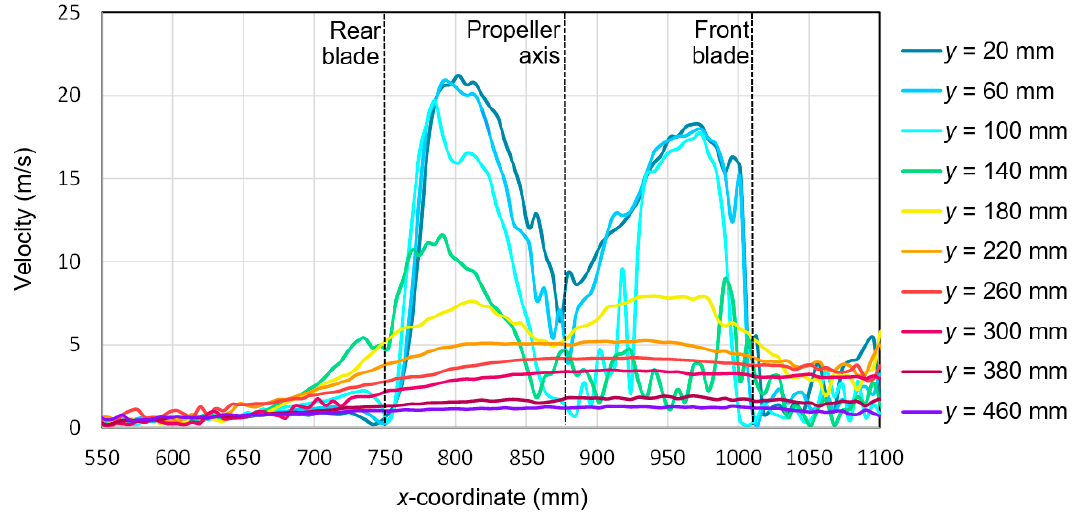
Figure 16. Resultant airflow velocities around the research object for the following configuration: angle of attack α = 0° and airflow in the wind tunnel v wt = 0 m/s.